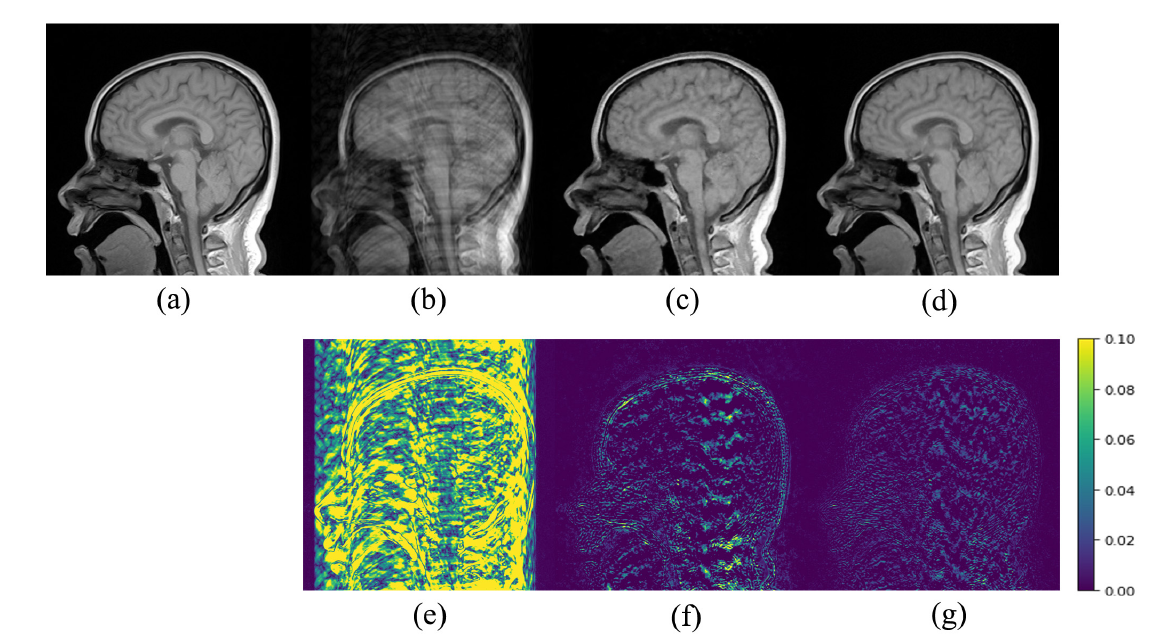
Figure 5. Comparison of the reconstruction results of the target MR image: ( a ) in Brain A using the Cartesian undersampled mask with 20% sampling rate; ( b ) zero-filling reconstruction; ( c ) DIP reconstruction; ( d ) the proposed method reconstruction and corresponding error maps ( e )–( g ).